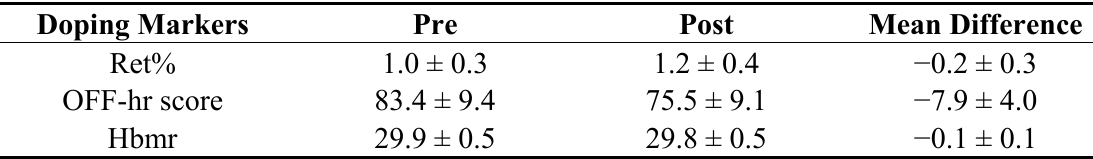
Table 1. Reticulocytes (Ret%), OFF-hr score and hybrid algorithm (Hbmr) values, pre- and post-supplementation of the hyperhydrating solution containing Gly, Cr and Glu. Data presented as Mean ± S.D. and mean differences (95% CI) of different hematological parameters calculated from pre- and post-supplementation values, N =